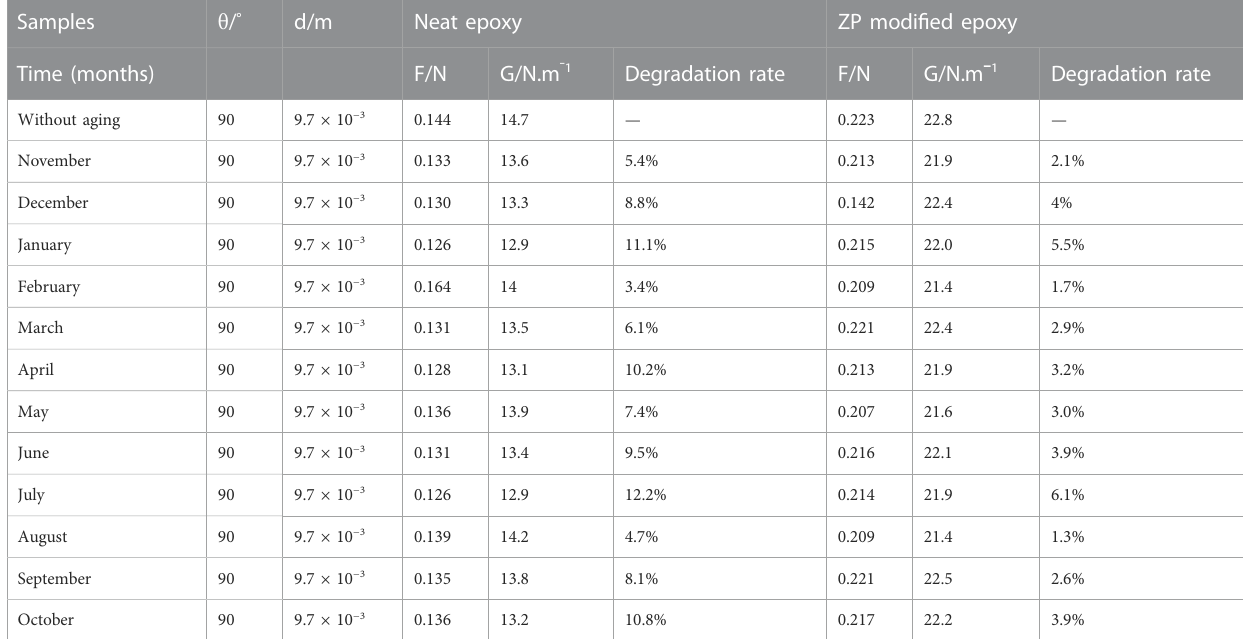
TABLE 2 Peeling-off force of the coating on Al alloy 6101 with ZP modi fi ed and near epoxy aging at 90 ° angle.